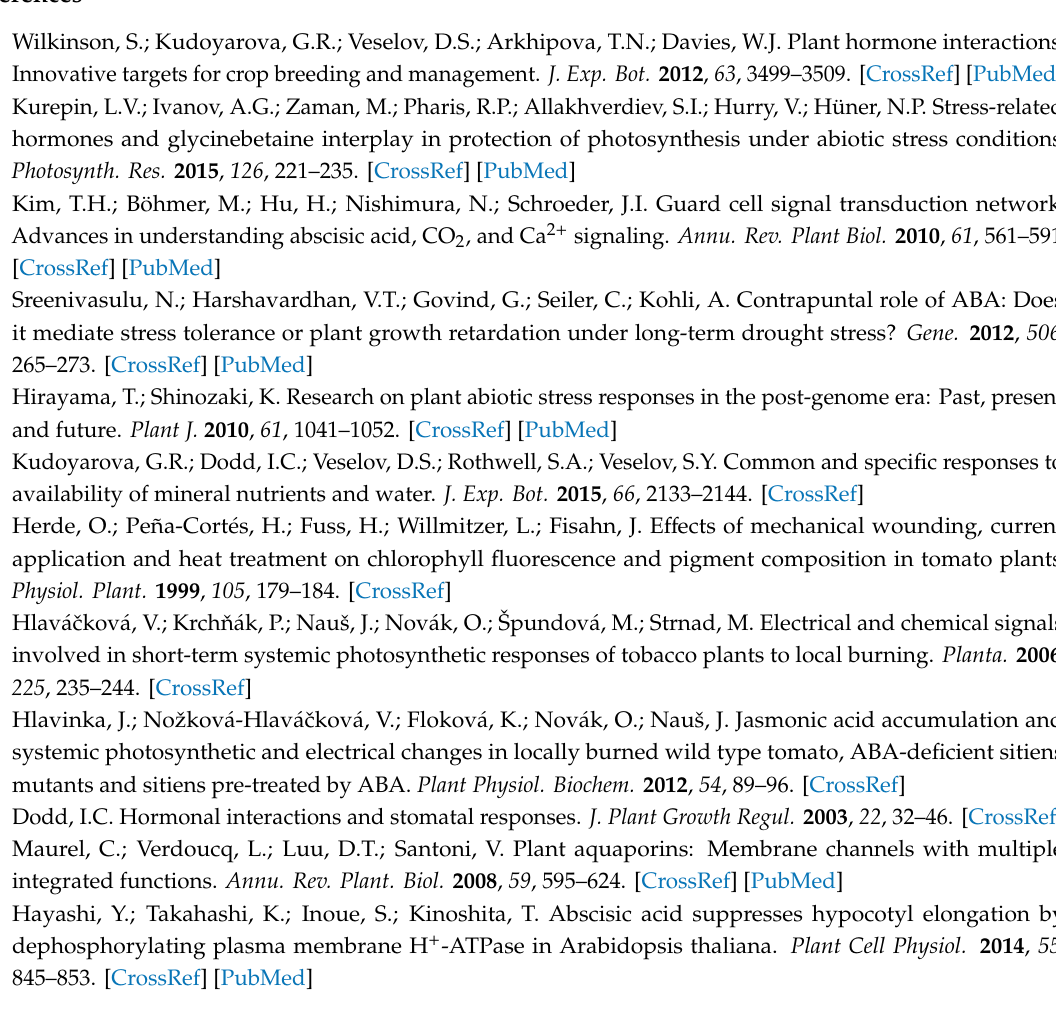
Figure S1: (a) Extracellular record of burning-induced variation potential (VP) in leaf of the control pea seedling. (b) Extracellular record of burning-induced variation potential (VP) in leaf of the ABA-treated seedling. (c) Average amplitudes of VP (AVP) in control seedlings and seedlings in 1 day after the ABA treatment at extracellular measurements ( n = 5–7). (d) The scatter plot between amplitudes of VP at extracellular measurements and magnitudes of VP induced decreases in A CO2 in pea seedlings ( ∆ A CO2 ) ( n = 12). Figure S2: Examples of measurements of the metabolic component of the resting potential in control (a), ABA-treated (b) and preliminarily OV-treated (c) pea